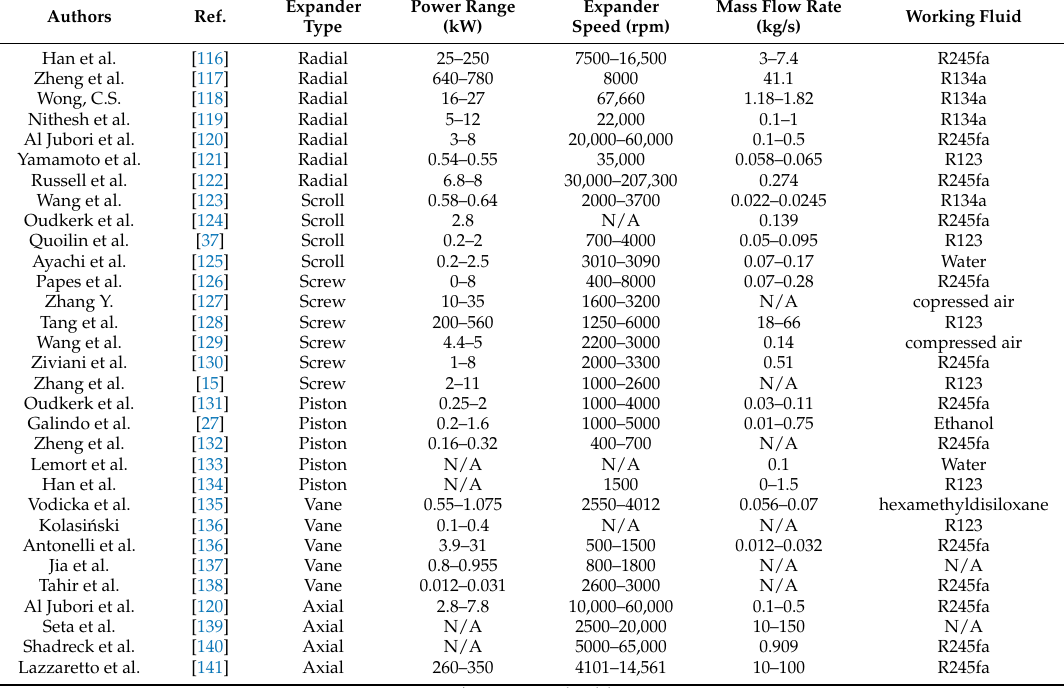
Table 1. Summary of ORC Studies with Different Expansion